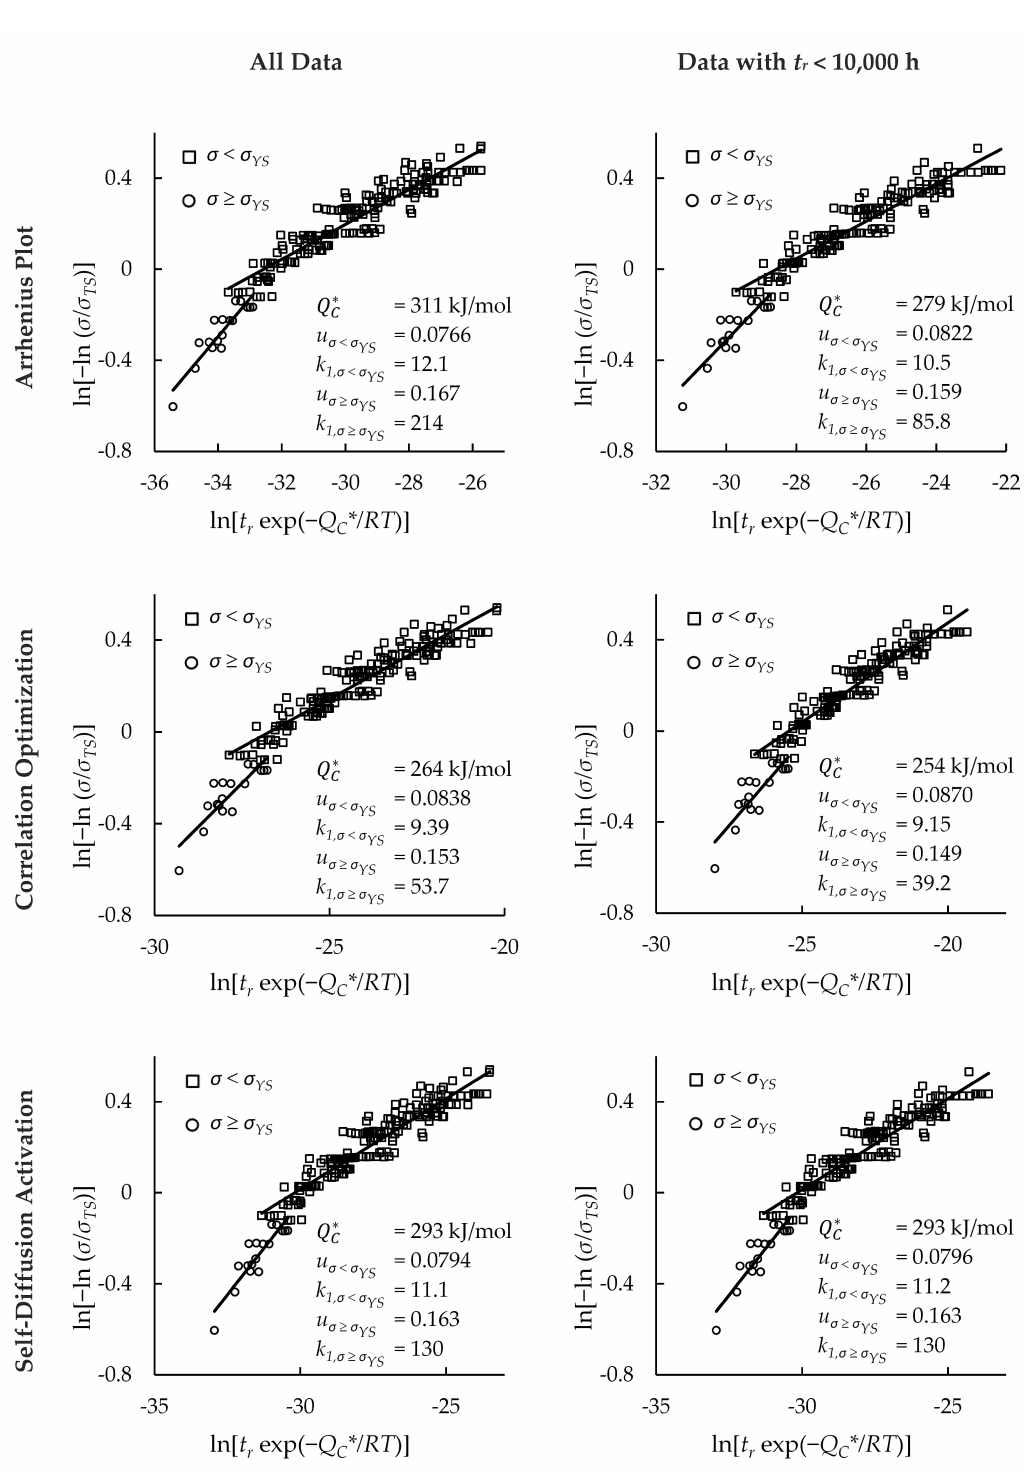
Figure A3. The effect of region-splitting on the goodness of fit of Wilshire plots for HR6W.